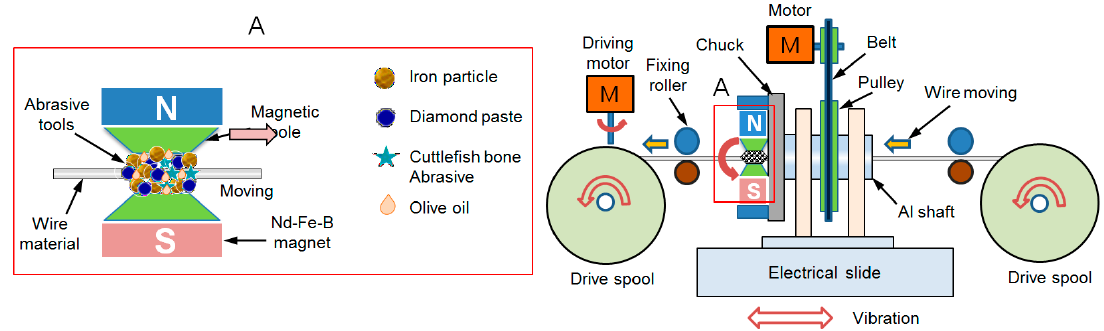
Figure 1. Schematic diagram of the wire magnetic abrasive finishing process using ecological magnetic abrasive finishing.